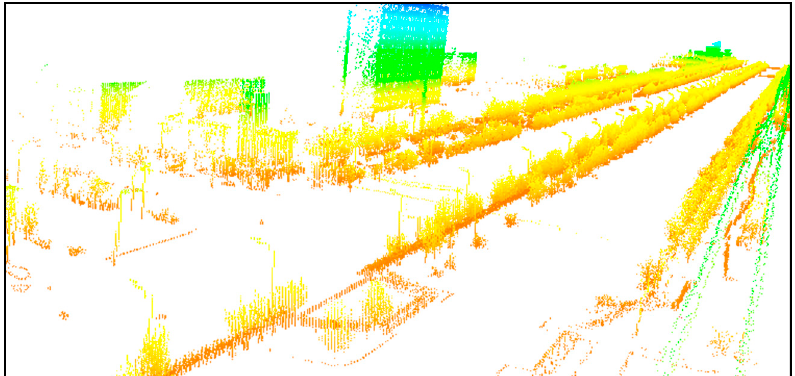
Figure 12. Original mobile point cloud data.